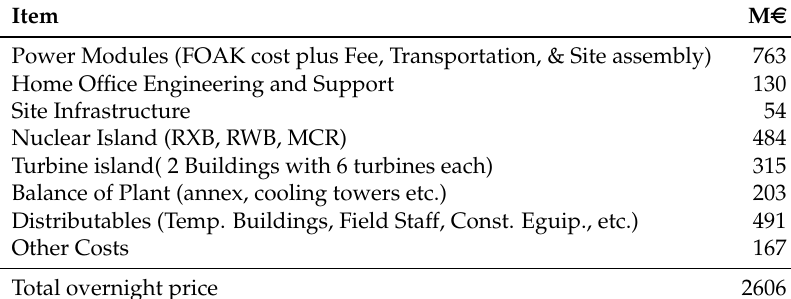
Table 3. 12-module NuScale plants overnight cost distribution